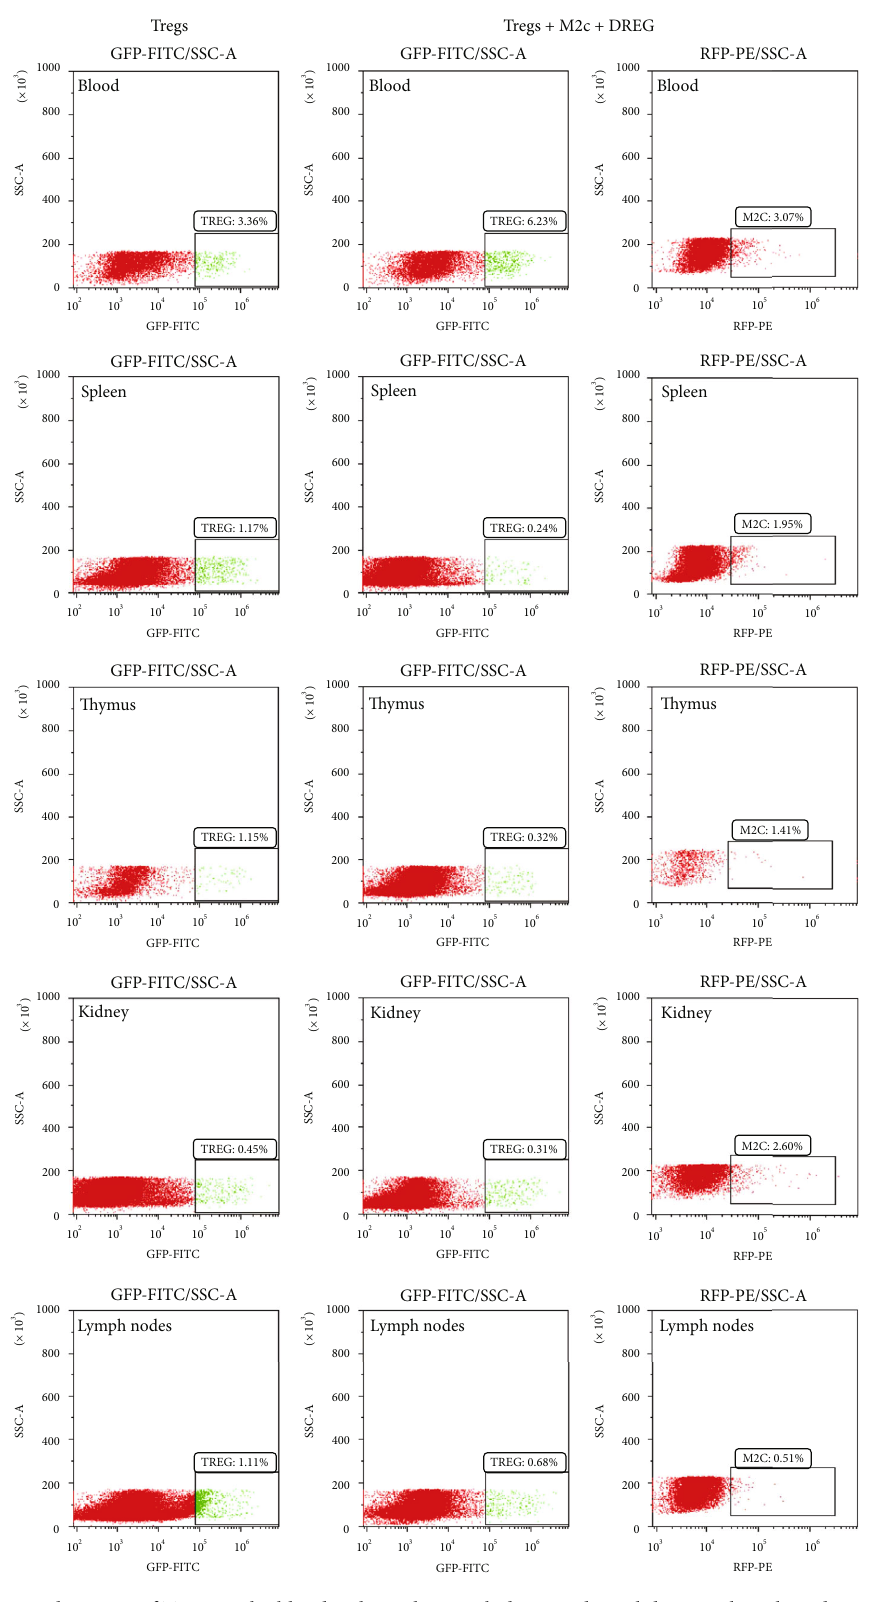
Figure 4: Flow cytometry detection of Tregs in the blood, spleen, thymus, kidney, and renal draining lymph nodes in animals treated with M2c macrophages+Tregs+DREG or only with Tregs. GFP: green fl uorescent protein; RFP: red fl uorescent protein; FITC: fl uorescein